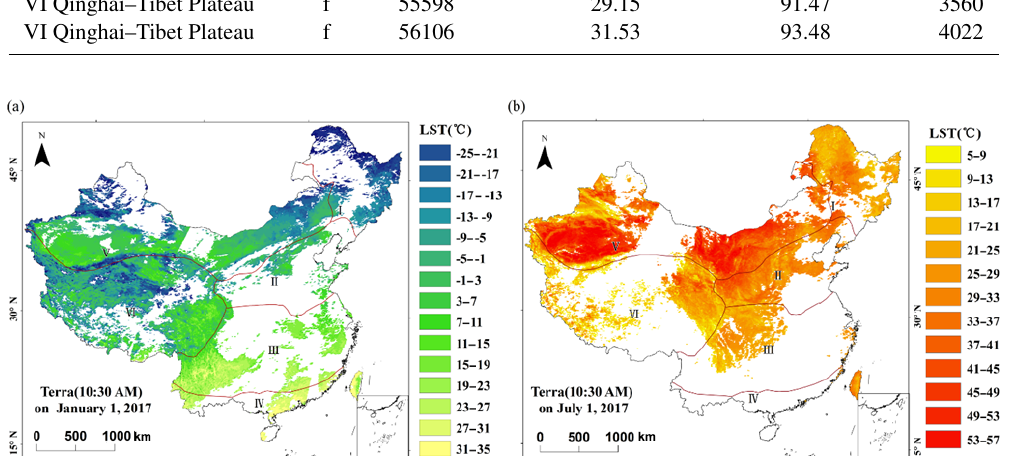
Figure 3. Spatial distribution of valid data for daily MODIS LST data from Terra during the daytime on (a) 1 January 2017 and (b) 1 July 2017. Areas of missing data are blank, and no filtering is performed (see text for details).